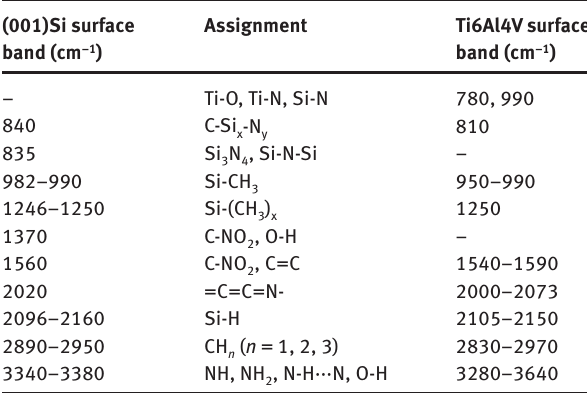
Fig. 10: FTIR spectra for SiC x (H)/(001)Si and SiC x (H)/alloy synthesis in series Table 3: Interpretation of FTIR spectra for synthesis systems [11–19].